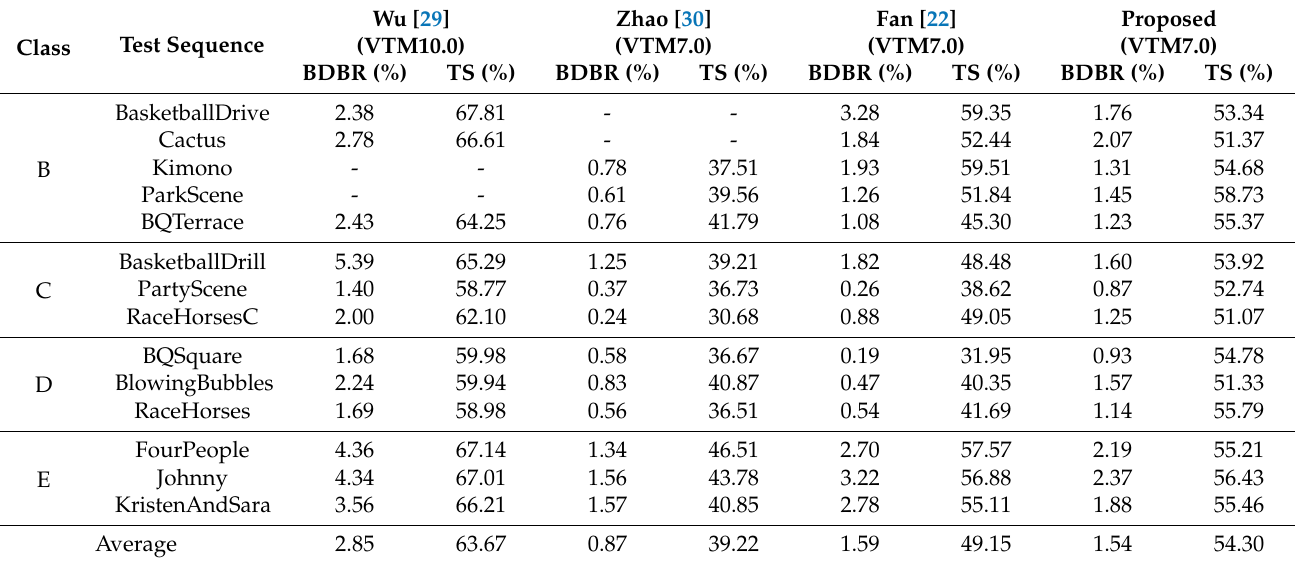
Table 2. Encoding performance of proposed algorithm compares with previous works.